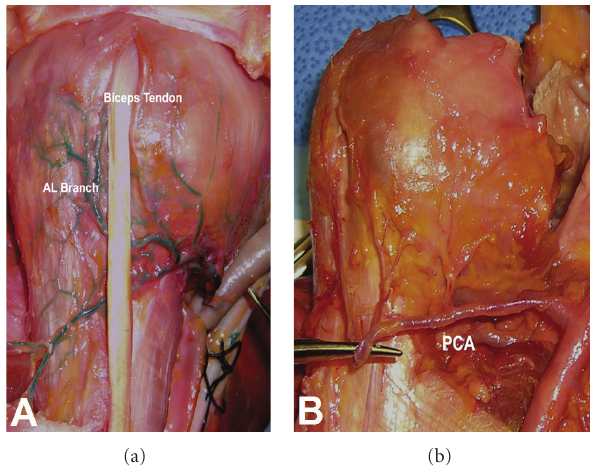
Figure 3: The anterior humeral circumflex is seen adherent to the proximal humerus (a), whereas the posterior humeral circumflex artery (PCA) seen in (b) is less adherent with several perforating branches along its course, making this vessel less vulnerable to injury in the case of proximal humerus fracture. (Reprinted with permission from Hettrich [10]).